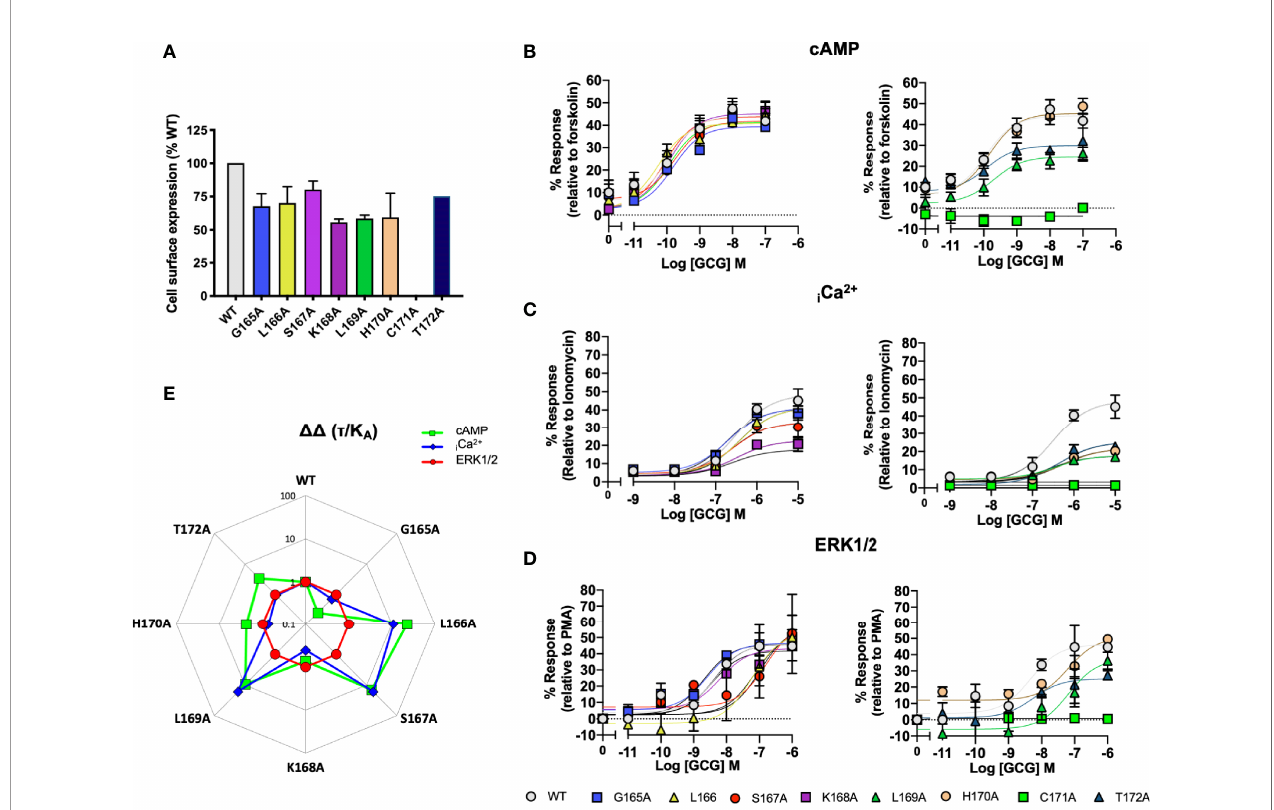
FIGURE 6 | Signaling bias of alanine mutants of ICL1 at the Glucagon receptor. Residues in the ICL1 were mutated to Ala and the effects on (A) Cell surface expression, normalized to wild type GCGR, (B) cAMP production, (C) elevation of i Ca 2+ , (D) ERK1/2 were compared to wild type receptor, (E) Signaling bias plot was calculated as 10 DD ( t /KA) for each mutant and each signaling pathway relative to WT and ERK1/2 phosphorylation. All data are mean ± SEM of n repeats where n=minimum of 3